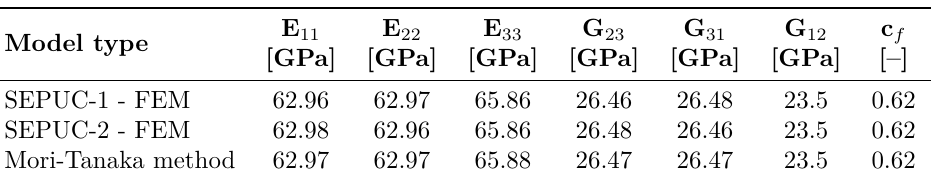
Table 3. Effective elastic moduli.